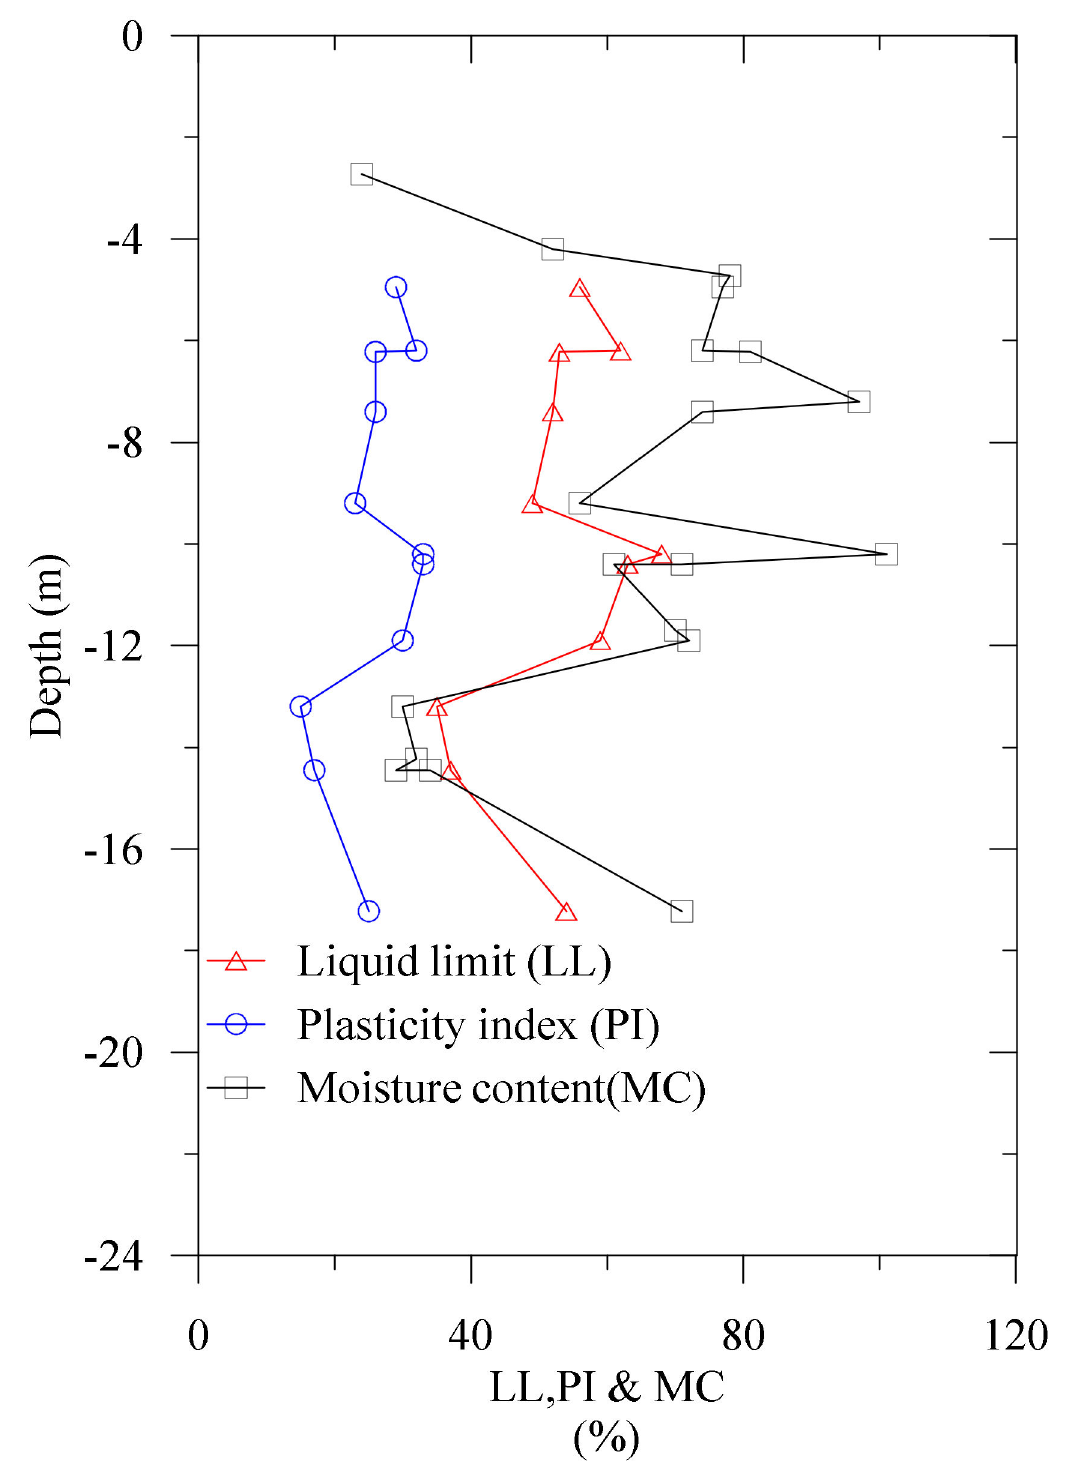
Figure 7. Liquid limit, plasticity index, and moisture contents of the Nerang Broadbeach Roadway embankment